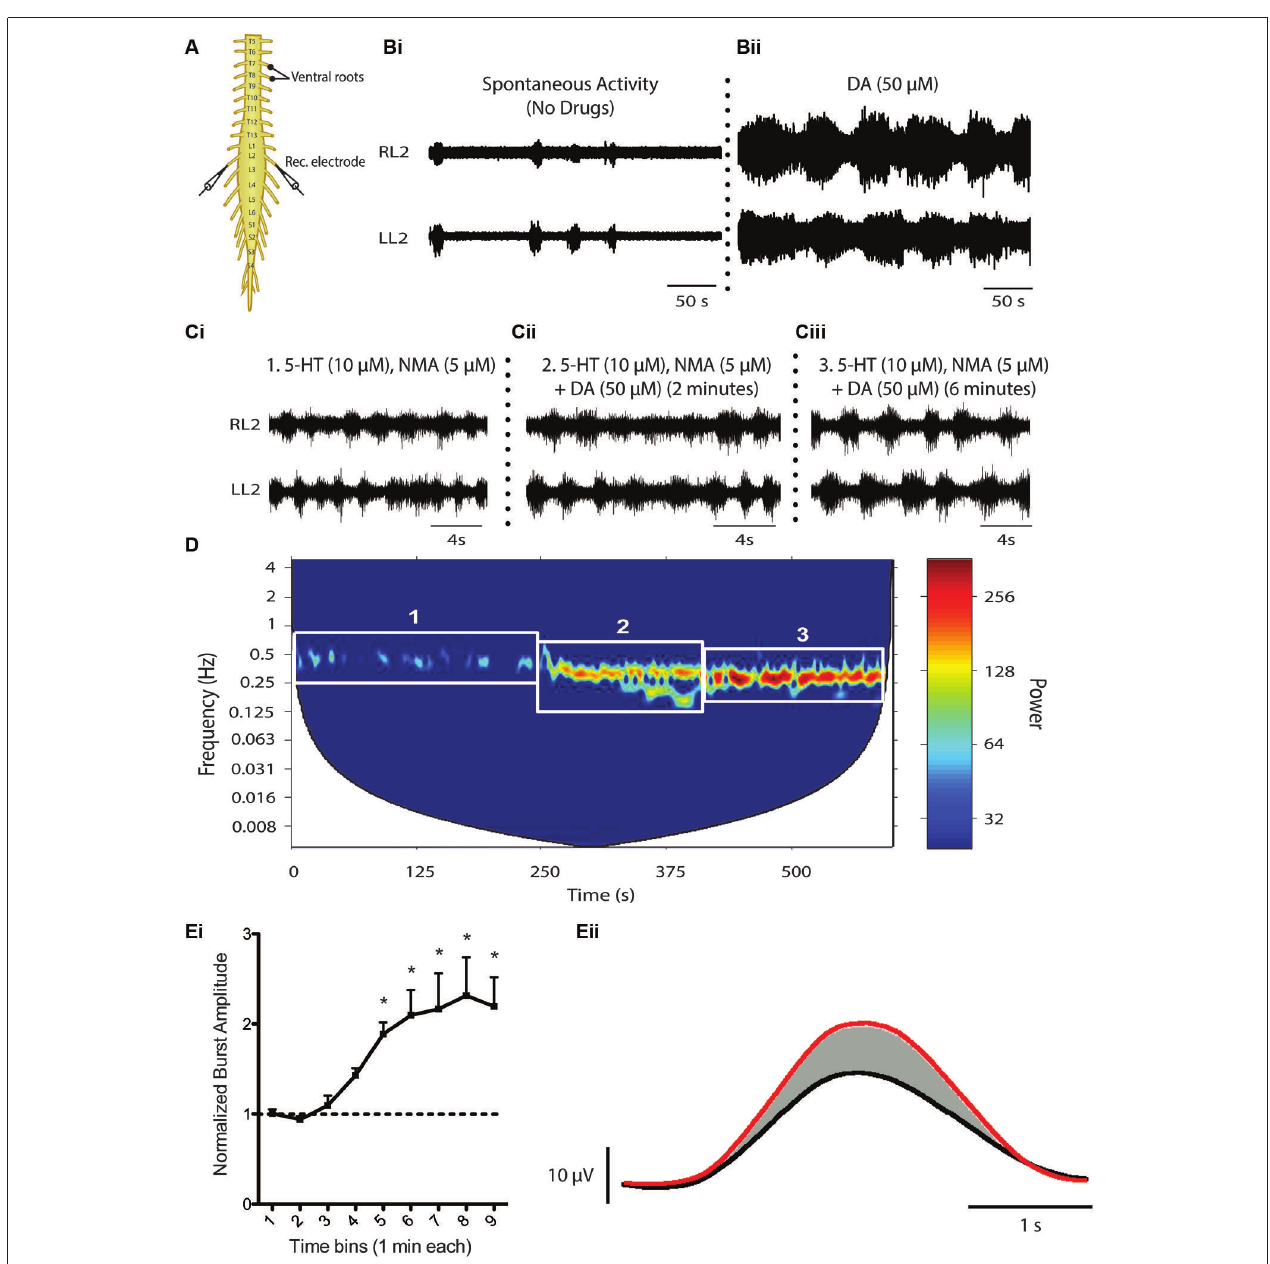
pre-existing rhythm (box 2 and 3). Rhythm frequency is displayed on the y -axis and rhythm power displayed as warm or cool colors with warmer colors representing higher power or more stable rhythm. Dopamine also increases burst amplitude (Ei and Eii) . (Ei) Graph displays an increase in burst amplitude over a 10 min period immediately following the addition of dopamine and (Eii) shows an average L2 neurogram burst from a representative experiment with bursts evoked by 5-HT and NMA (black) and following addition of dopamine (red) (Adapted from Humphreys and Whelan,